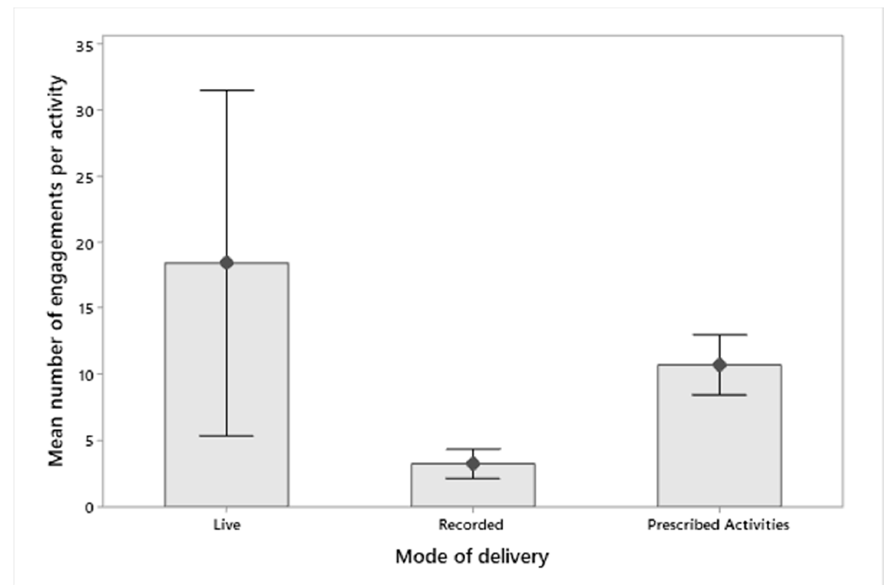
Figure 1. Mean number of interactions per activity across the three modes of delivery (error bars represent standard error of the mean).